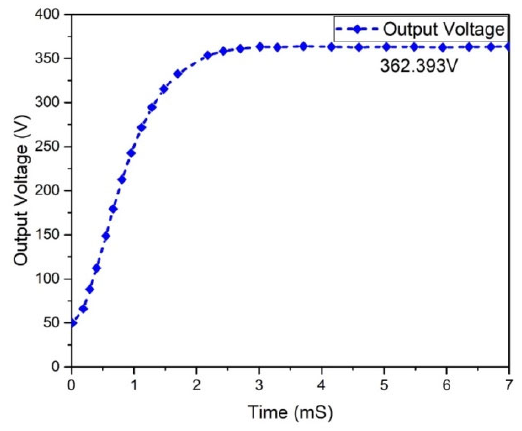
Figure 12. Boost converter output voltage.